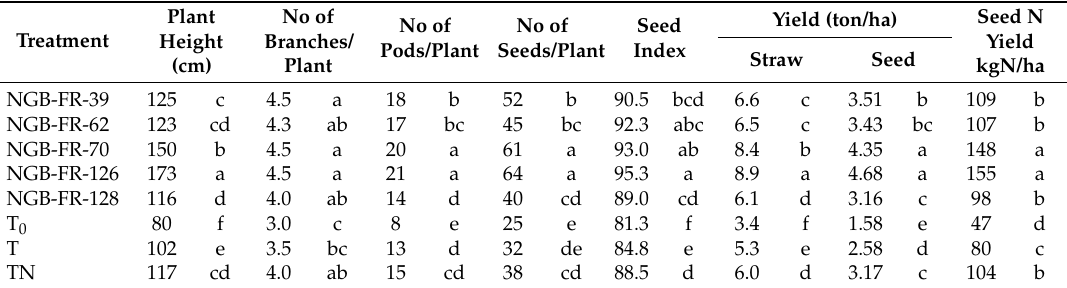
Table 6. Effect of different rhizobial strains on different growth parameters and yield of faba bean plants under field conditions (winter growing season